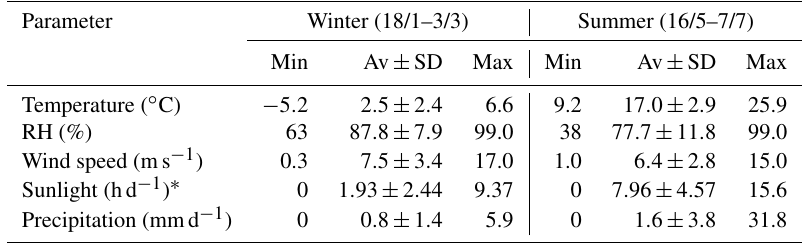
Table 2. Meteorological conditions during measurement campaigns: average, lowest, and highest values.